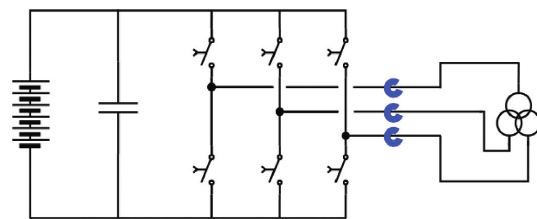
Figure 6: Traction inverter phase current sensing with the mag- netic field-based sensors.